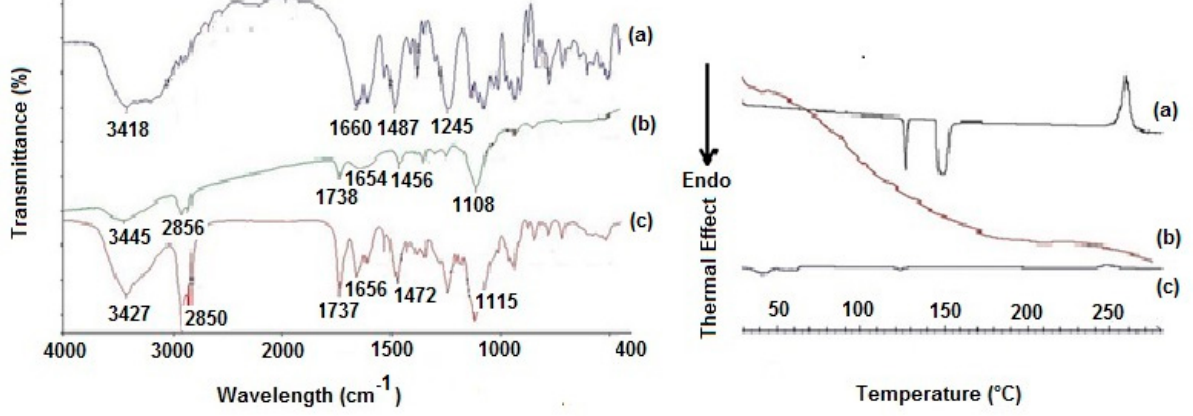
Figure 2. Left panel: FT-IR spectra of ( a ) pure CIT, ( b ) plain SLNs and ( c ) CIT-SLNs. Right panel: DSC profiles of ( a ) pure CIT, ( b ) plain SLNs and ( c ) CIT-SLNs.